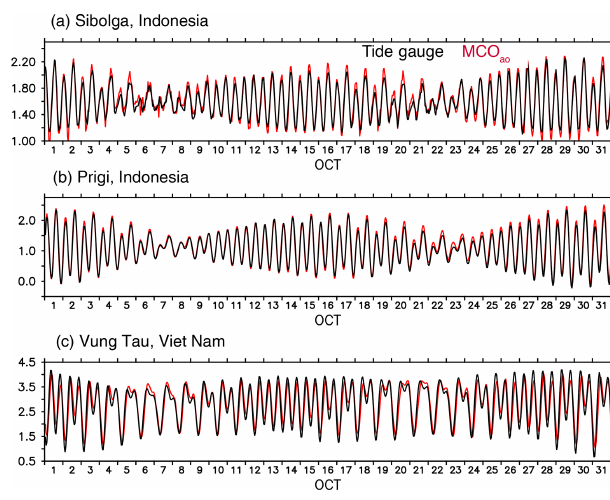
Figure 10. Time series of hourly instantaneous SSH (in metres) from tide gauge observations (black line) and a MCO ao forecast lead time of 1d (fcst_day1, red line) at randomly selected stations, (a) Sibolga (1.75 ◦ N, 98.767 ◦ E), (b) Prigi (8.28 ◦ S, 111.73 ◦ E), and (c) Vung Tau (10.34 ◦ N, 107.072 ◦ E), during October 2019.